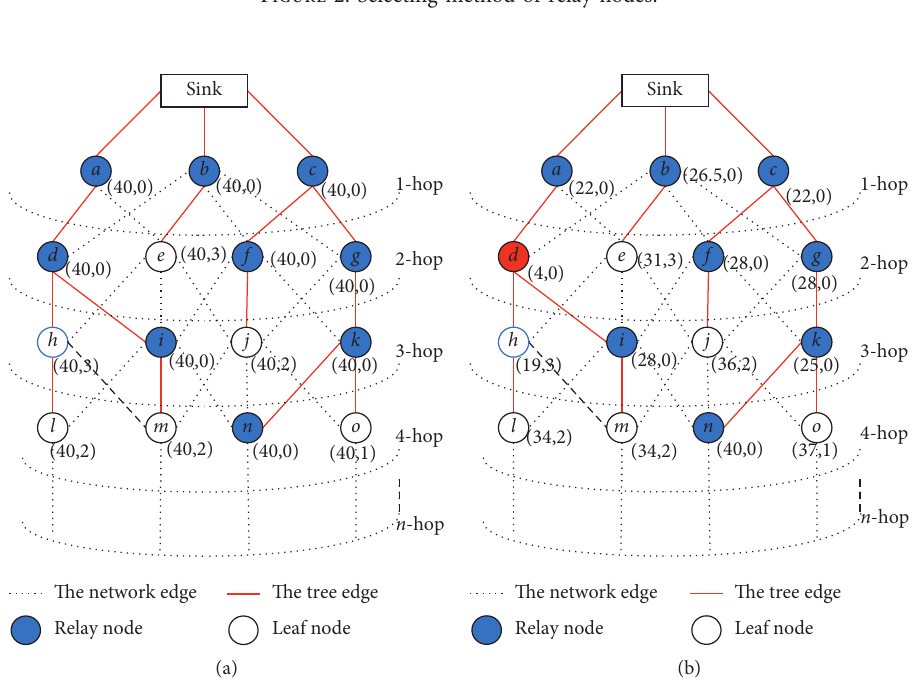
Figure 3: Energy consumption diagram.